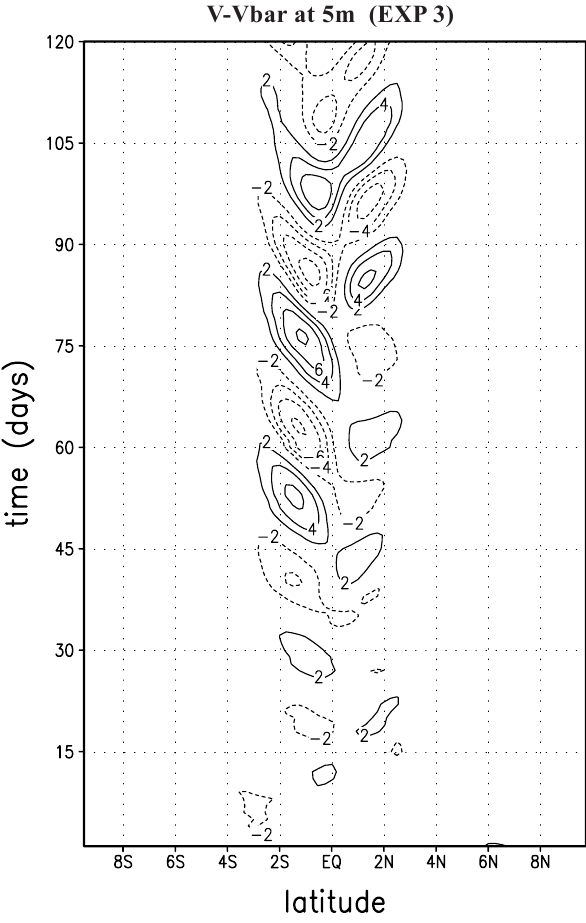
Fig. 2. Time-latitude diagram of perturbation meridional velocity at 5m for EXP 3. Contour interval is